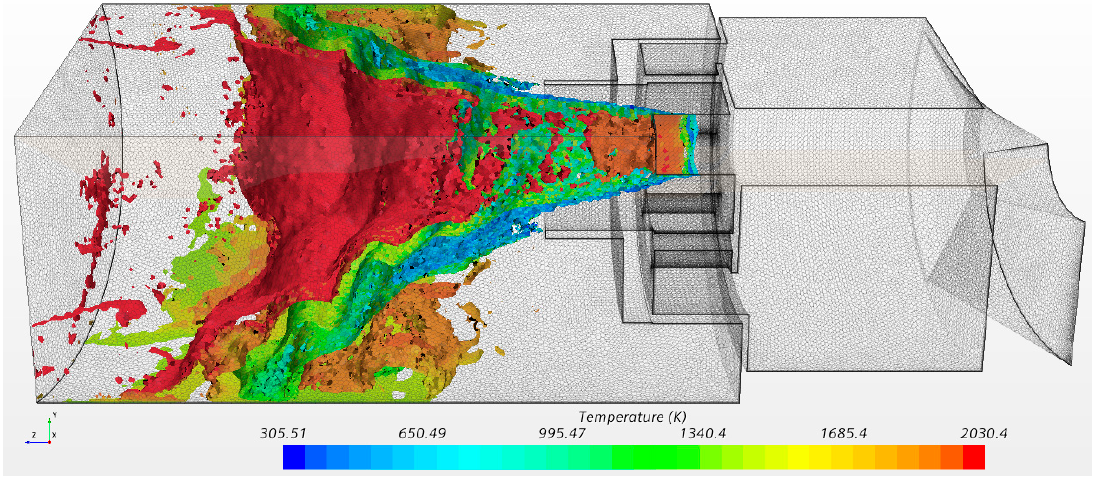
Figure 6. Isosurface of NO reduction ( − 0.1 kg/m 3 ·s) over-imposed on temperature profiles.